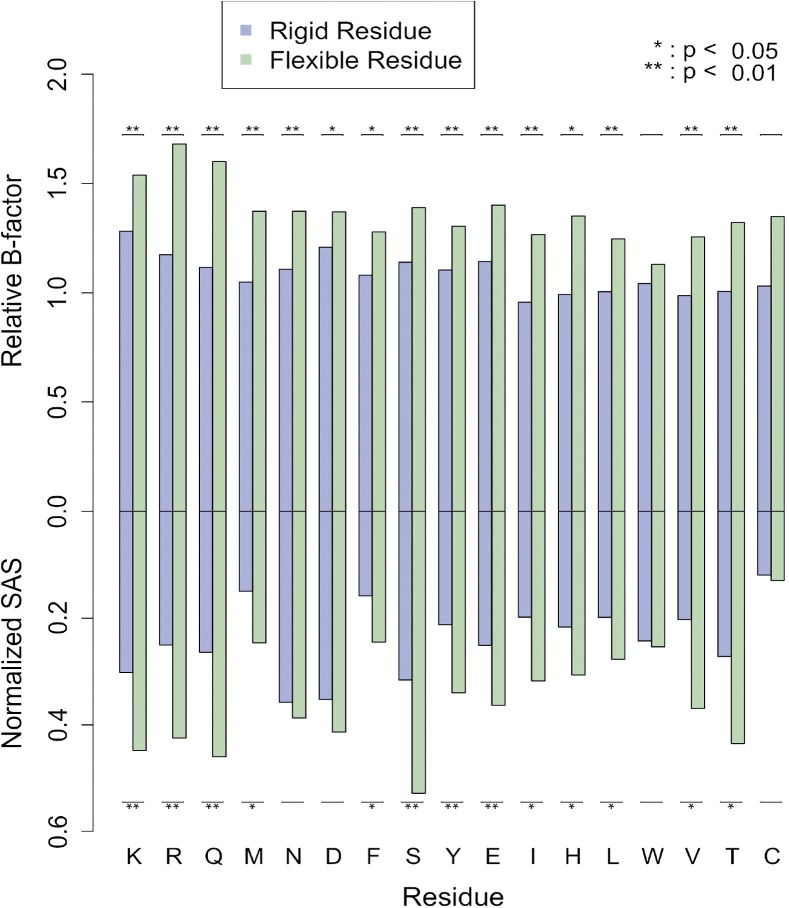
b-Factor and SAS analysis in the unbound form. In upper part, the freedom of movement in the unbound form is quantified using b-factors whereas the lower part represents the normalized solvent accessible surface areas (SAS). Rigid (blue) and flexible (green) residues are compared. Residues are ordered in respect to the flexibility scale. Student t-tests are used for statistical significance